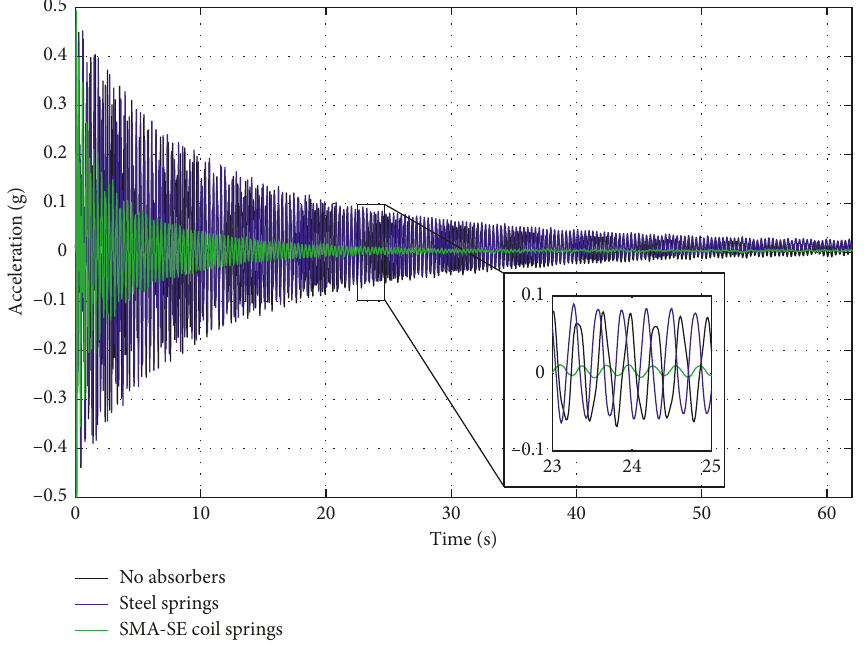
Figure 13: Time response for structure subjected to an impact in all